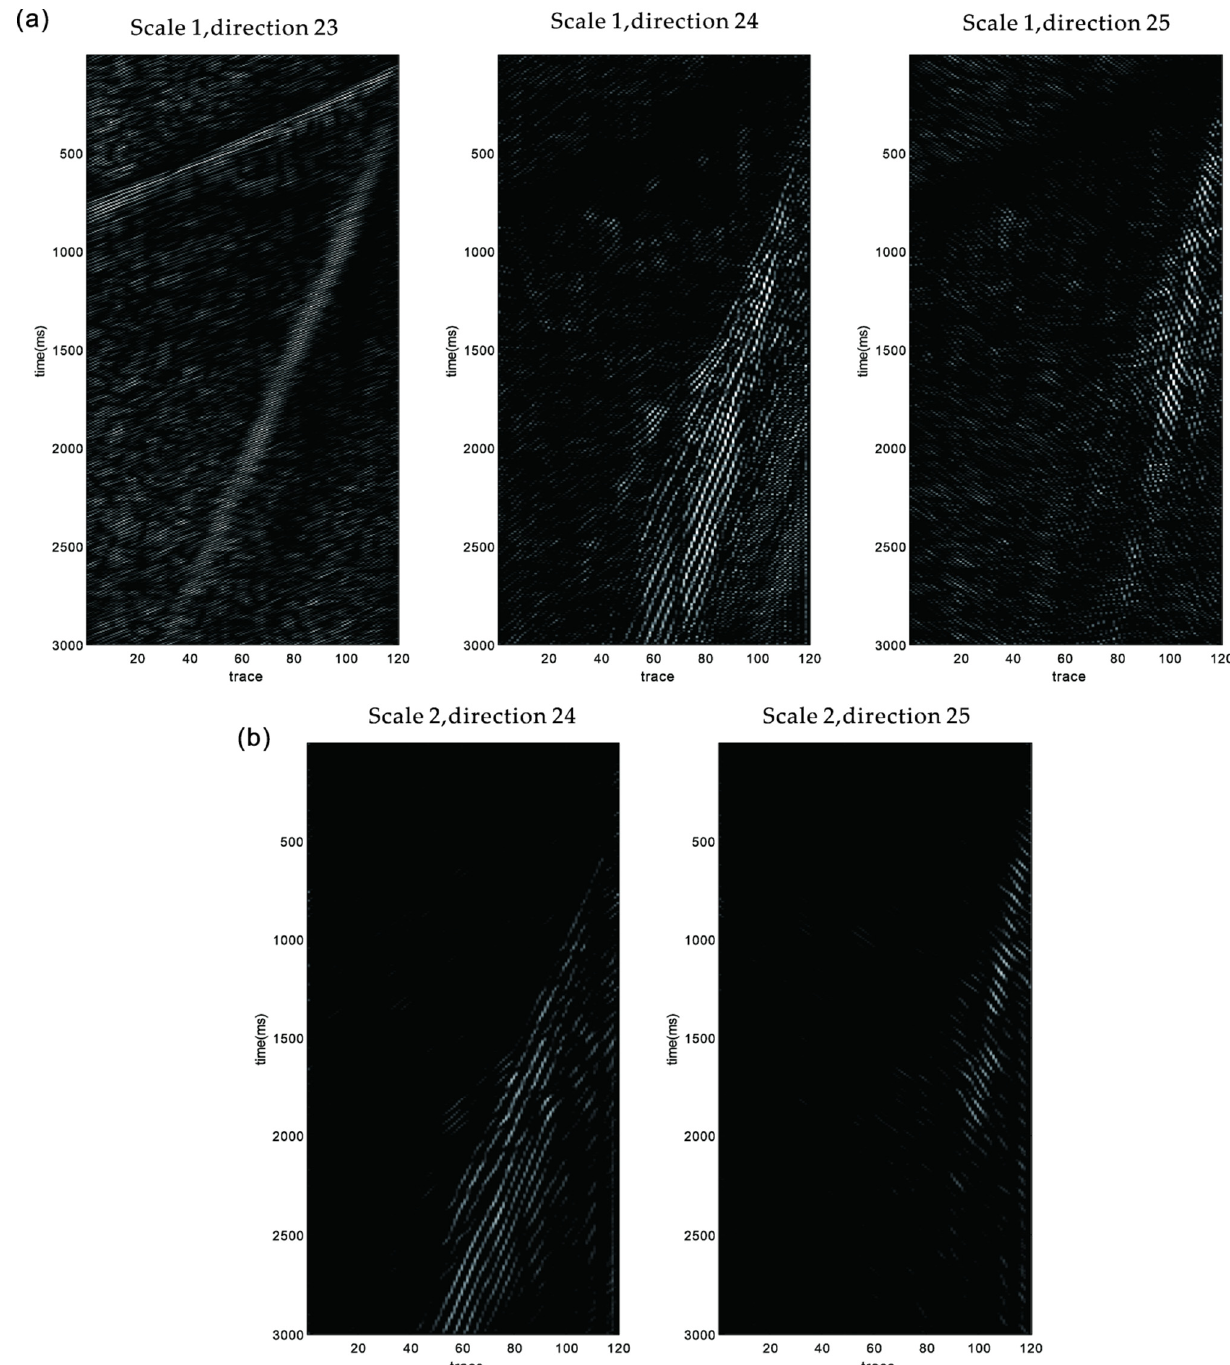
Figure 8. The main NSST coefficients containing the coherent noise. ( a ) The detail NSST coefficients at scale 2, 2 directions. ( b ) The detail NSST coefficients at scale 1, 3 directions.